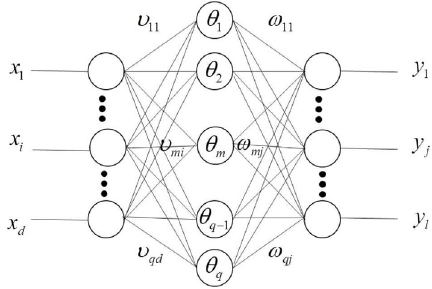
Fig. 2 Kernel mapping